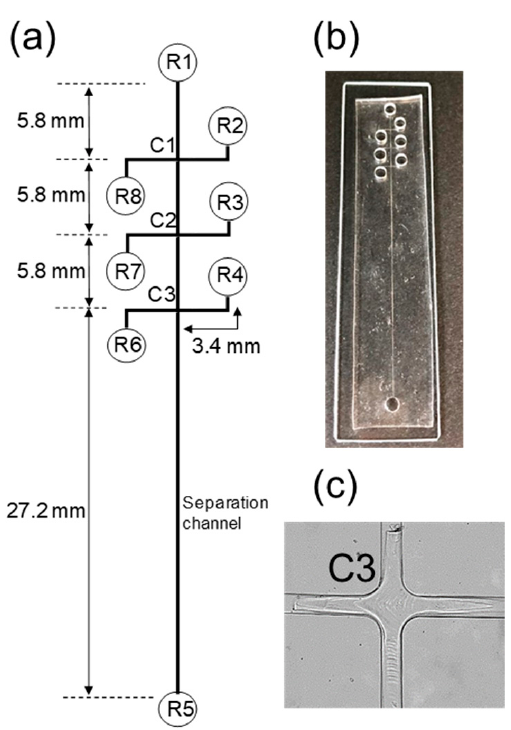
Figure 1. Schematic diagram of polydimethylsiloxane (PDMS)/glass microchip ( a ); photograph of the PDMS/glass microchip ( b ); Phos-tag acrylamide gel formed at the channel crossing point ( c ). R1 = dissociation buffer reservoir; R2 = washing buffer reservoir; R3 = buffer reservoir; R4 = fluorescent reagent waste reservoir; R5 = alkaline buffer reservoir; R6 = fluorescent reagent waste reservoir; R7 = fluorescent reagent reservoir; R8 = sample reservoir, C1–C3 = channel crossing point.